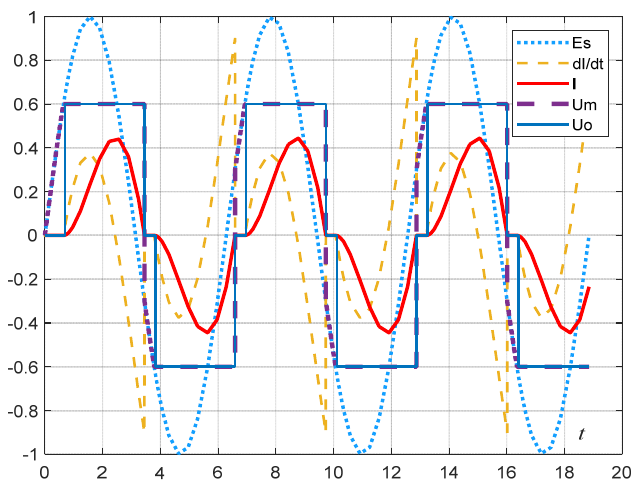
Figure 3. Voltage and current waveforms of the circuit model with nonlinear load and voltage observer for u a = 0.6, r = 0.1.